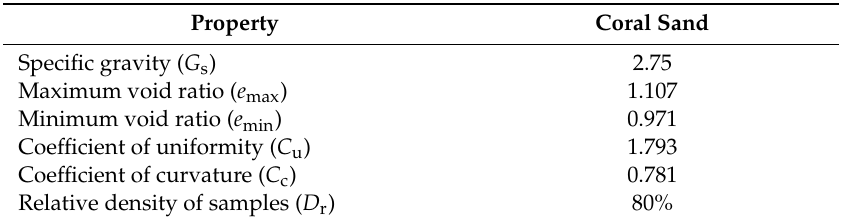
Table 1. Basic physical and mechanical parameters of test sand samples.